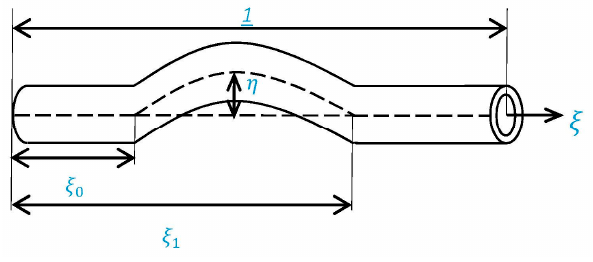
Figure 2. Schematic of initial imperfection of the nano-beam.